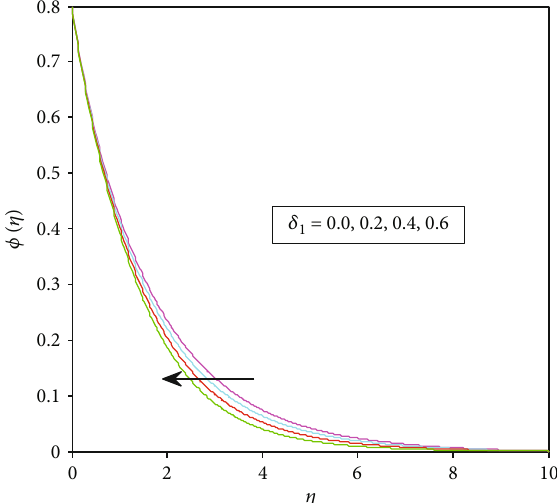
Figure 19: Concentration distribution for di ff erent values of the thermal strati fi cation